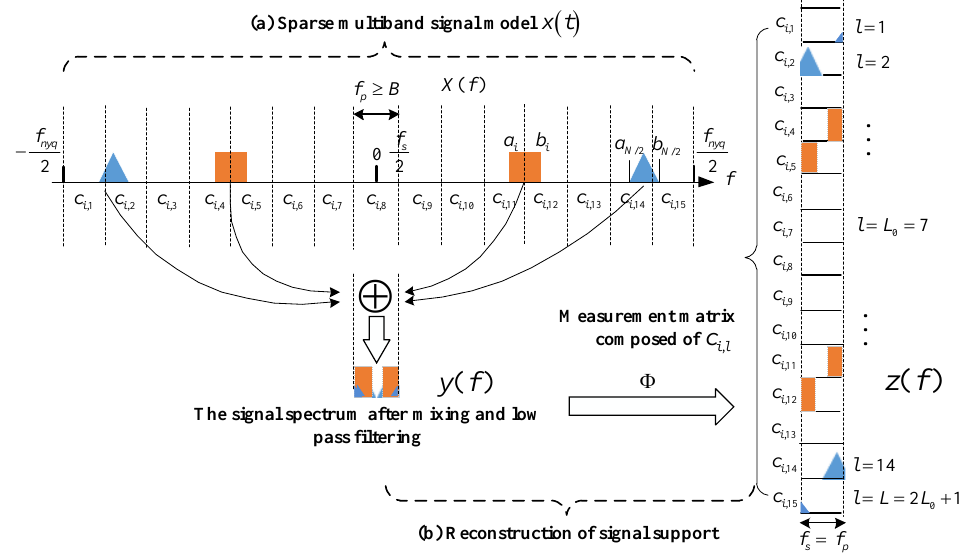
Figure 1. ( a ) Sparse multiband signal model; Figure 1. The principles of the MWC system [16,17]. ( a ) Sparse multiband signal model; ( b ) ( b ) Reconstruction of signal Reconstruction of signal support.